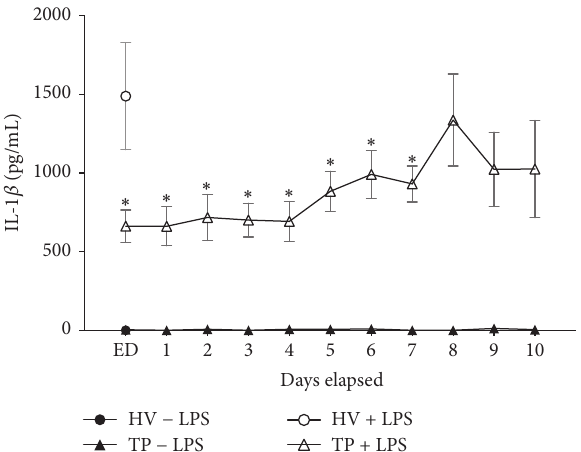
Figure 2: Major trauma leads to reduced IL-1 𝛽 release from whole blood after LPS stimulation. Whole blood from healthy volunteers (HV, 𝑛 = 14 ) or major trauma patients (TP, 𝑛 = 29 ) was stimulated with LPS. Supernatants were collected after 24h for measurements of IL-1 𝛽 by ELISA. A 10-day time course after admission (emergency department, ED–10) was made. To address unspecific stimulation, corresponding blood samples were incubated as described above without LPS stimulation. Data are shown as mean ± SEM. ∗ 𝑝 < 0.05 versus LPS-stimulated HV.